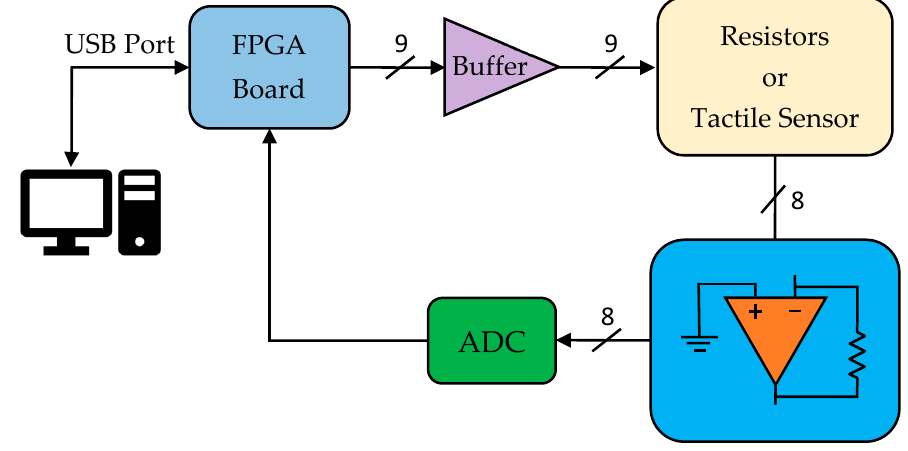
Figure 6. Block diagram of the whole system.